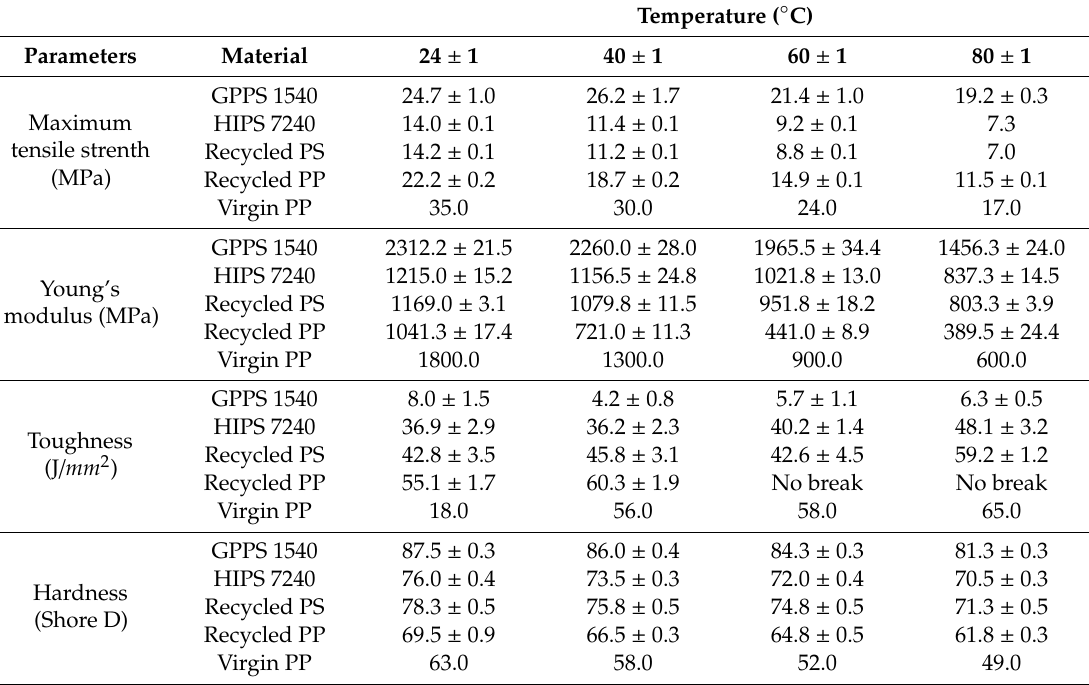
Table 2. Summary of the results for the polymers obtained from thermo-mechanical